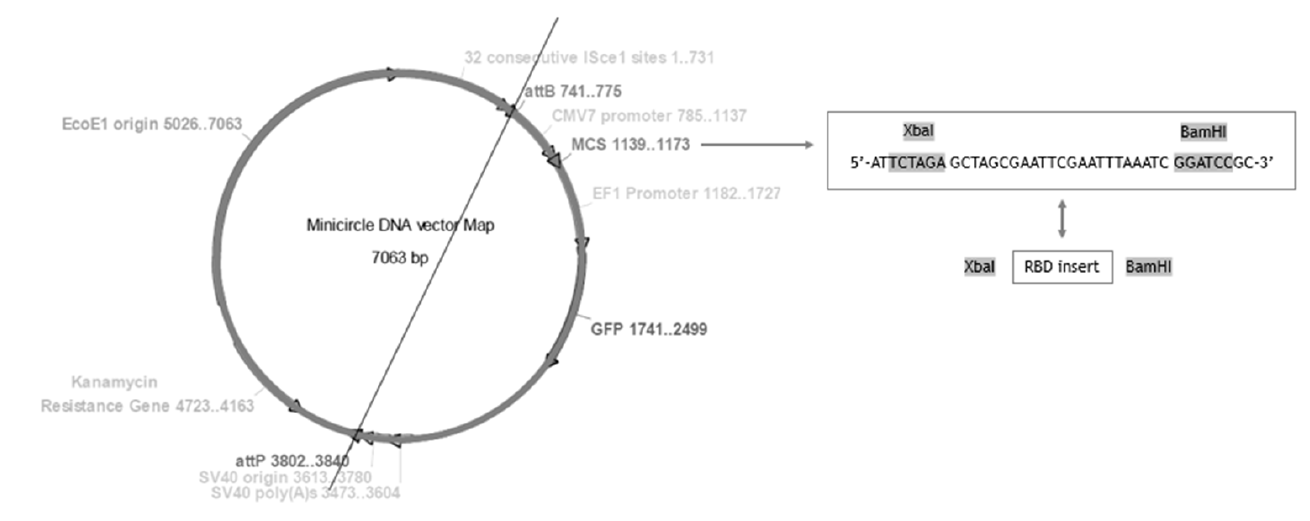
Figure 2. Minicircle DNA vector map for PP-RBD construction and restriction enzyme map.